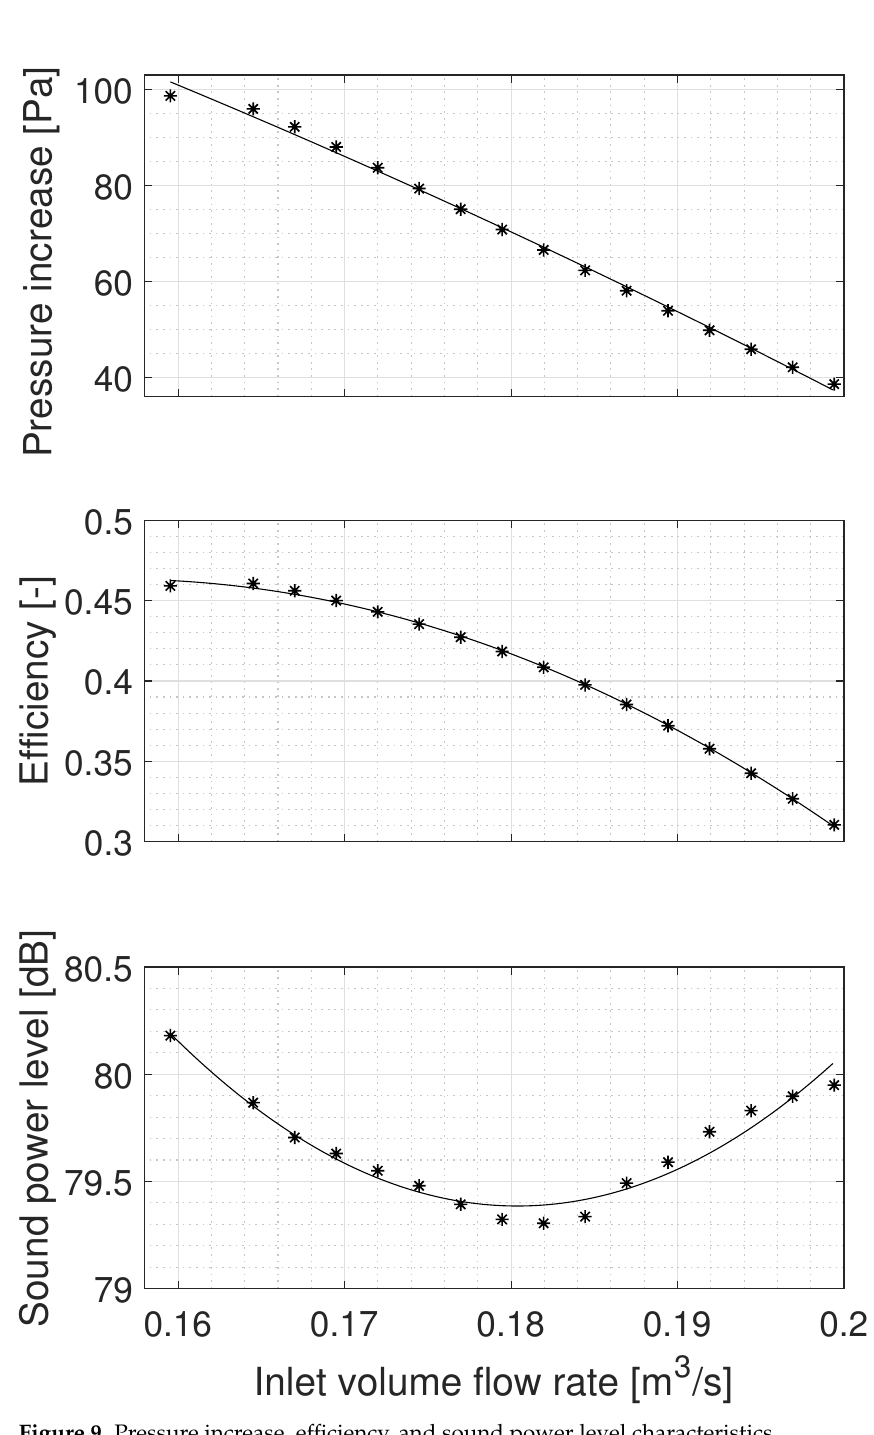
Figure 9. Pressure increase, efficiency, and sound power level